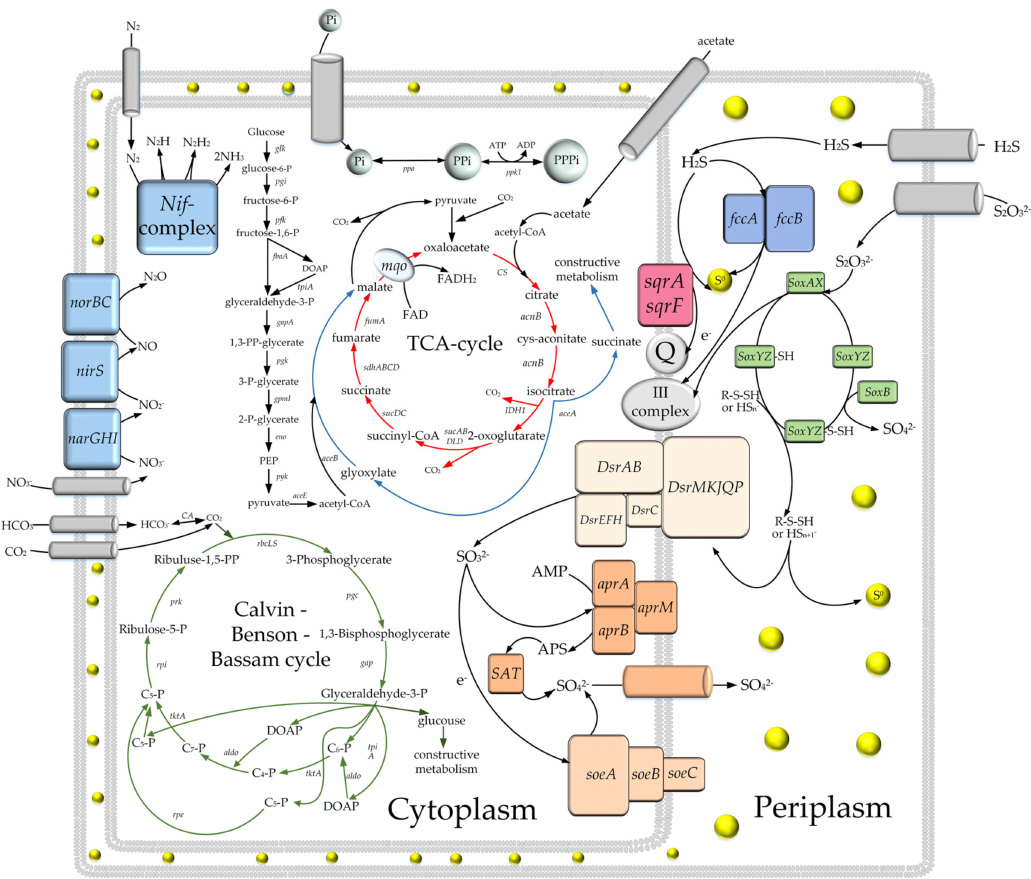
Figure 4. A hypothetical metabolic scheme for Thiothrix sp. RT and Thiothrix sp. SSD2 reconstructed from the received MAGs. The nirS gene encoding nitrite reductase was not found in the Thiothrix sp. RT